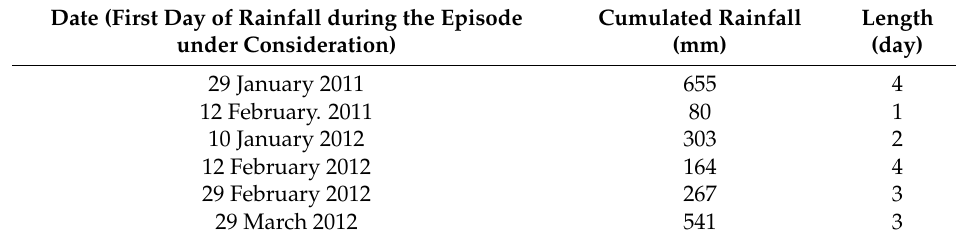
Table 3. Characteristics of rainfall episodes that generated significant aquifer recharge between January 2011 and December